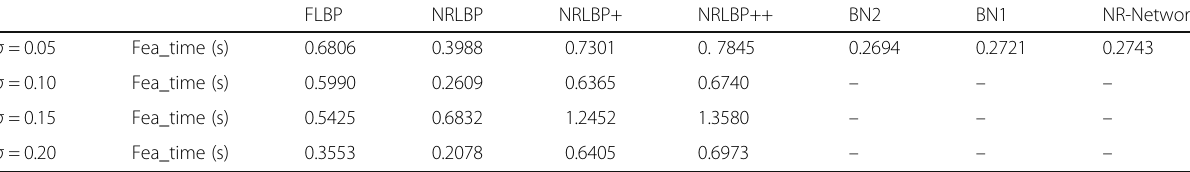
Table 6 The feature extraction time (Fea_time) of different methods on the AR database injected with Gaussian noise FLBP